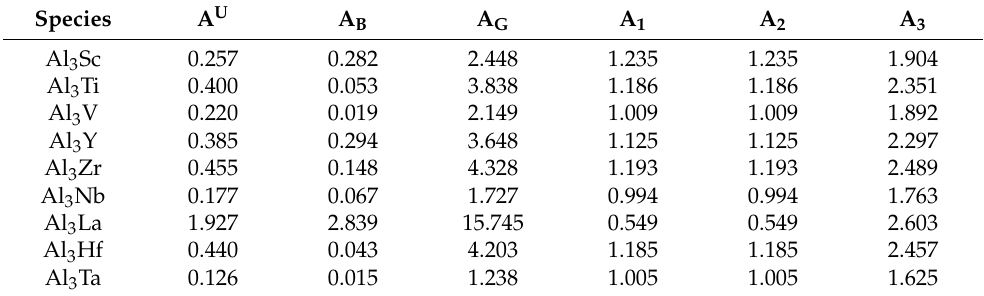
Table 4. The calculated universal anisotropic index (A U ), percent anisotropy (A B and A G ) and shear anisotropic factors (A 1 , A 2 and A 3 ) of Al 3 TM compounds. Species A U A B A